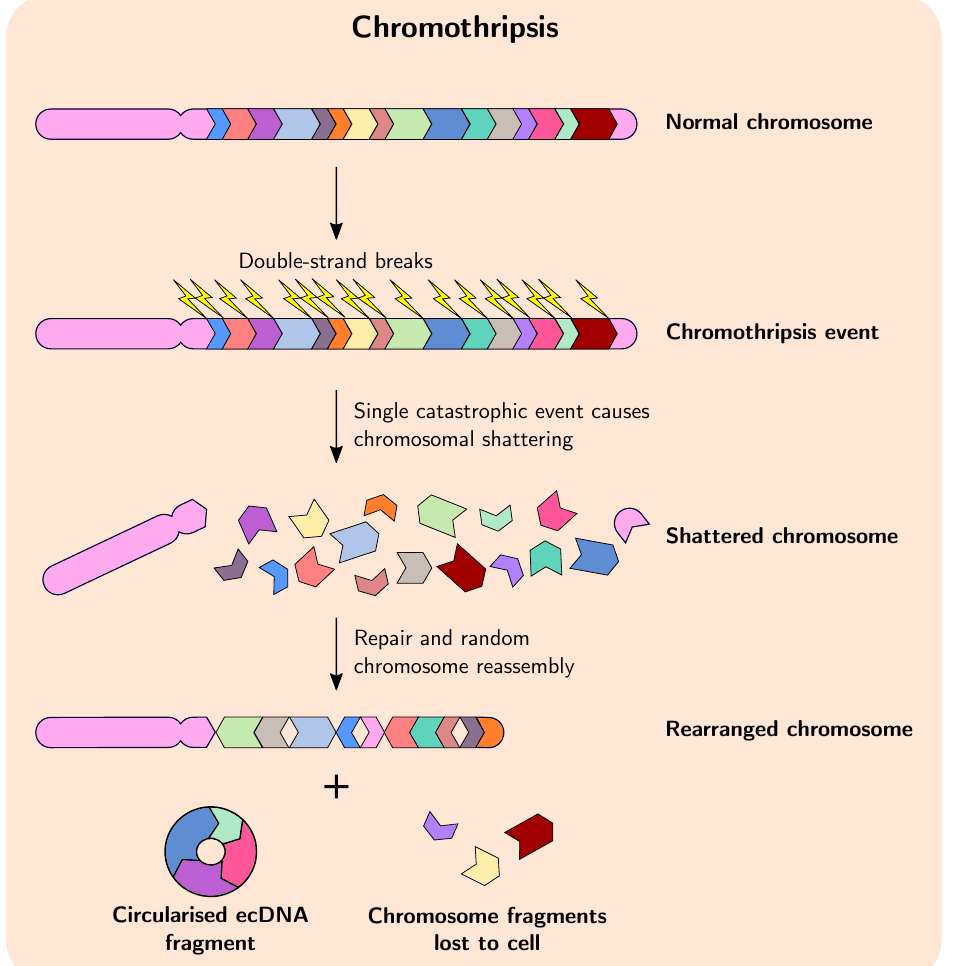
Figure 1. Overview of the process of chromothripsis in cancer. A single massive shattering event breaks up one or more chromosomes into multiple segments, which are then repaired and re- assembled randomly to form new, rearranged chromosomes. Some segments can form circularised extracellular DNA fragments, and some can be lost to the